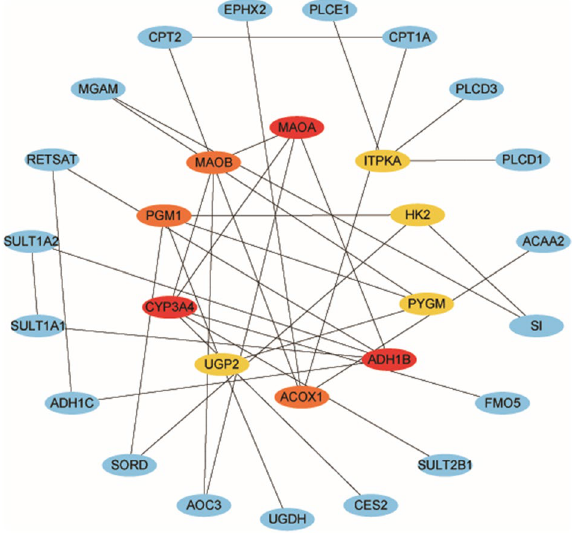
Figure 11. PPI network of the top 10 interconnected genes in the blue